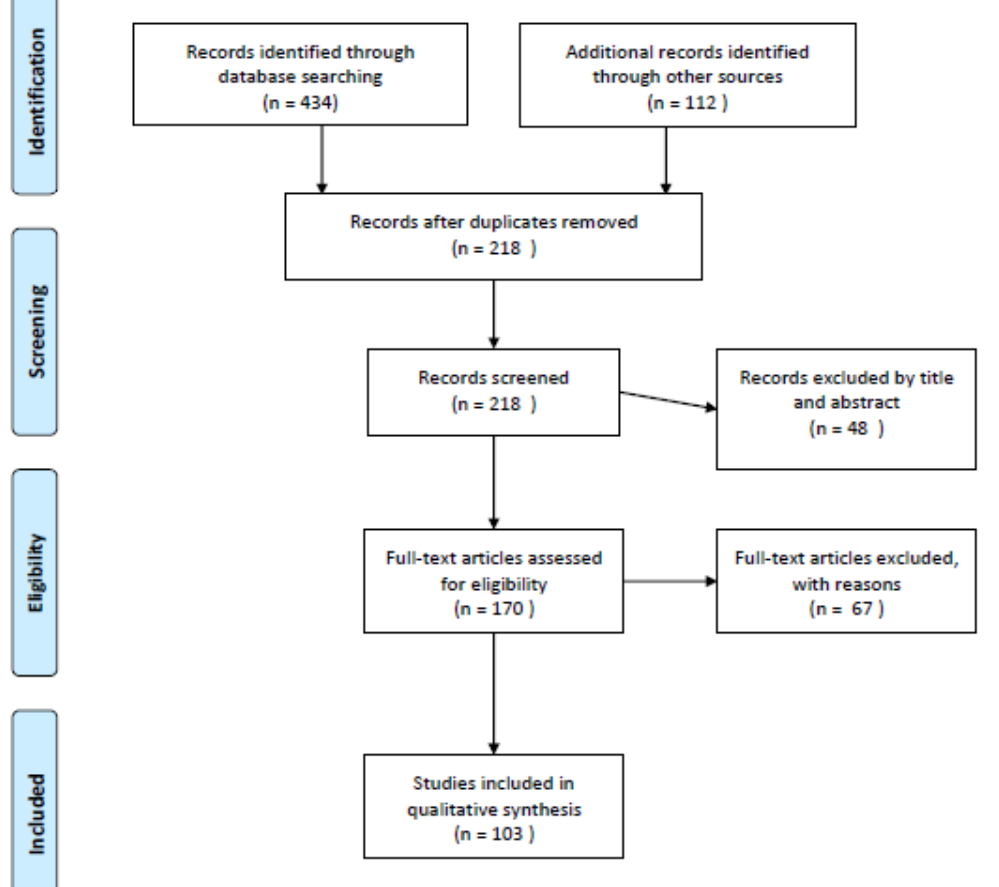
Figure 1. Flow diagram of the literature selection process.